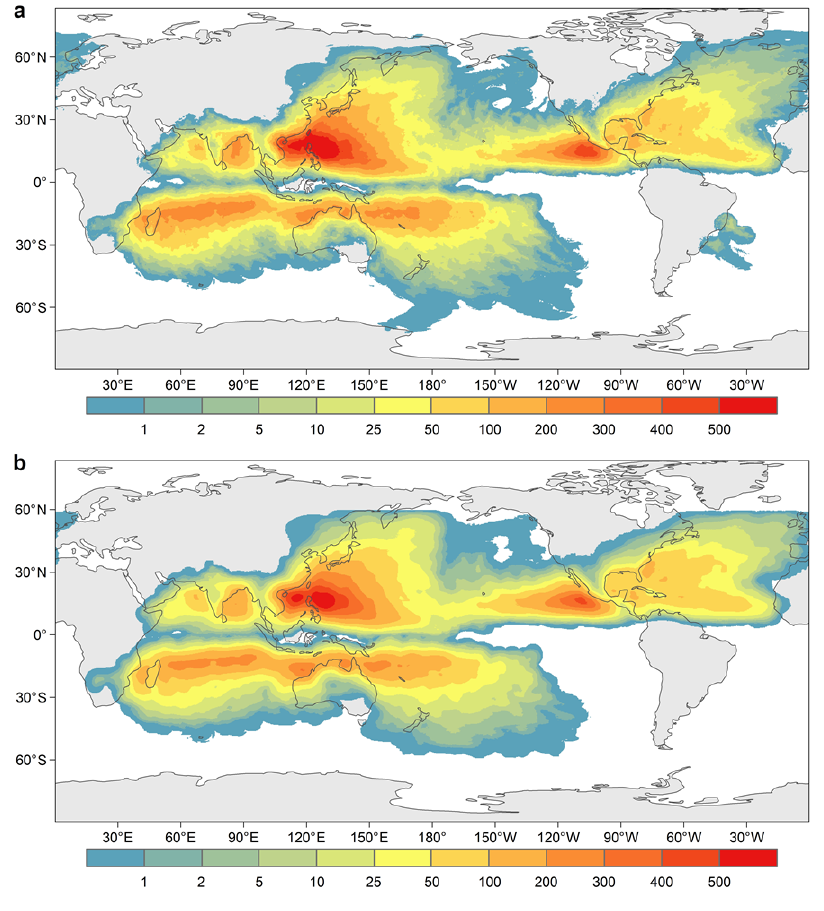
Figure A2. Spatial distribution of global mean annual tropical cyclone rainfall from 1980 to 2020. ( a ): Historical tropical cyclone rainfall. ( b ): Simulated tropical cyclone rainfall.